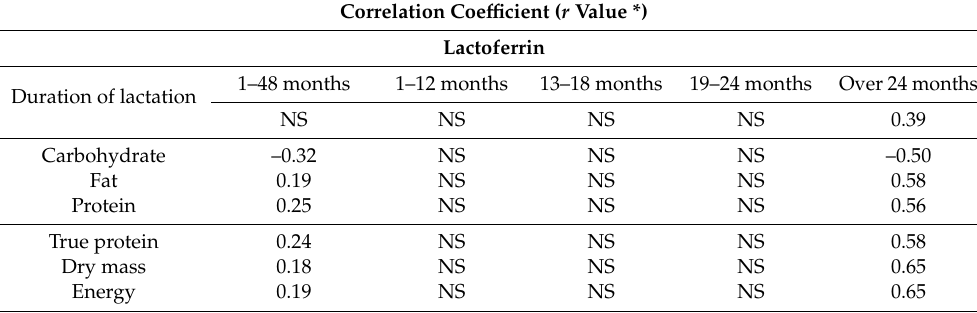
Table 3. Correlations between lactoferrin and macronutrients over prolonged lactation from month 1 to 48 and for particular